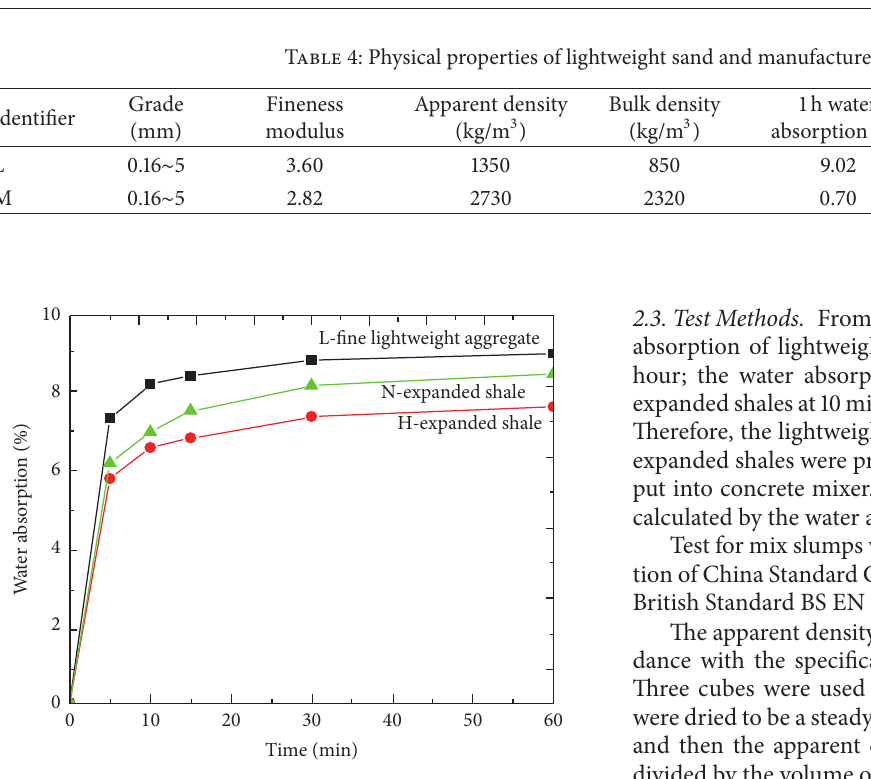
Figure 1: Water absorption of lightweight aggregates changing with